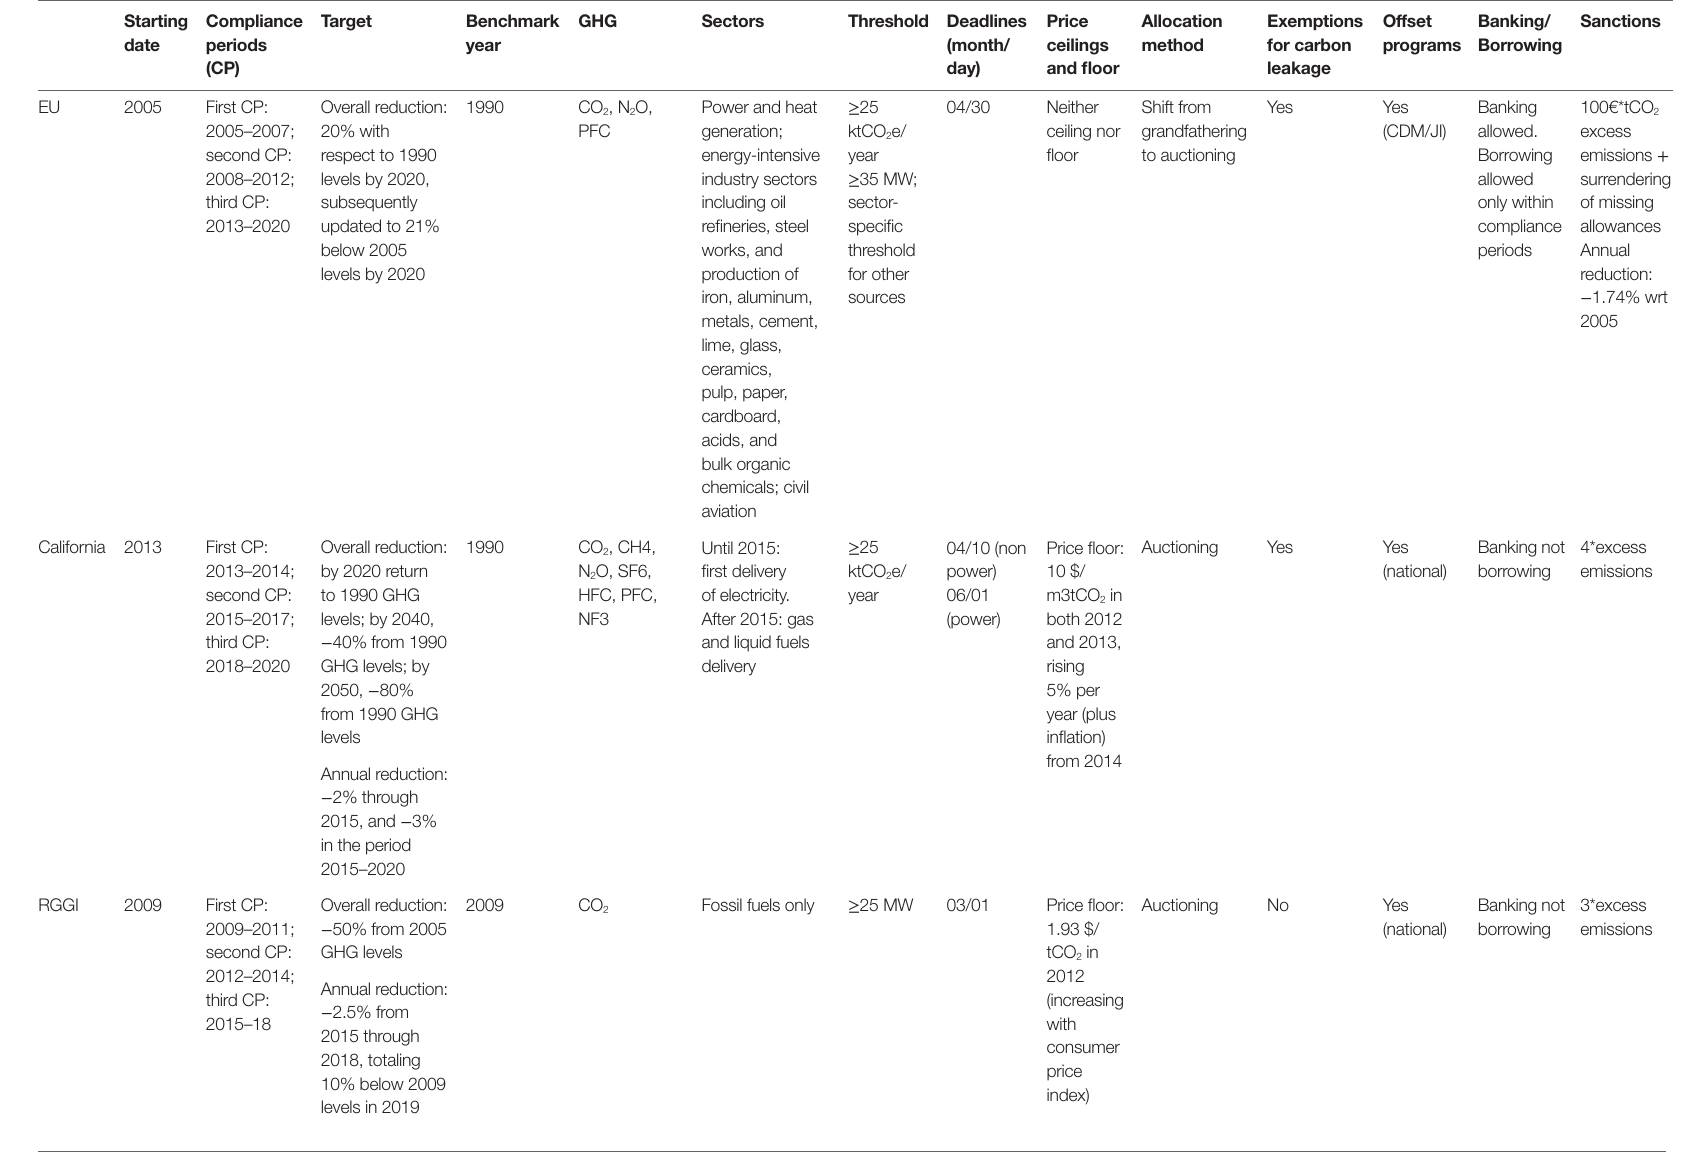
TABLe 1 | The eU eTS and the other main eTSs: a